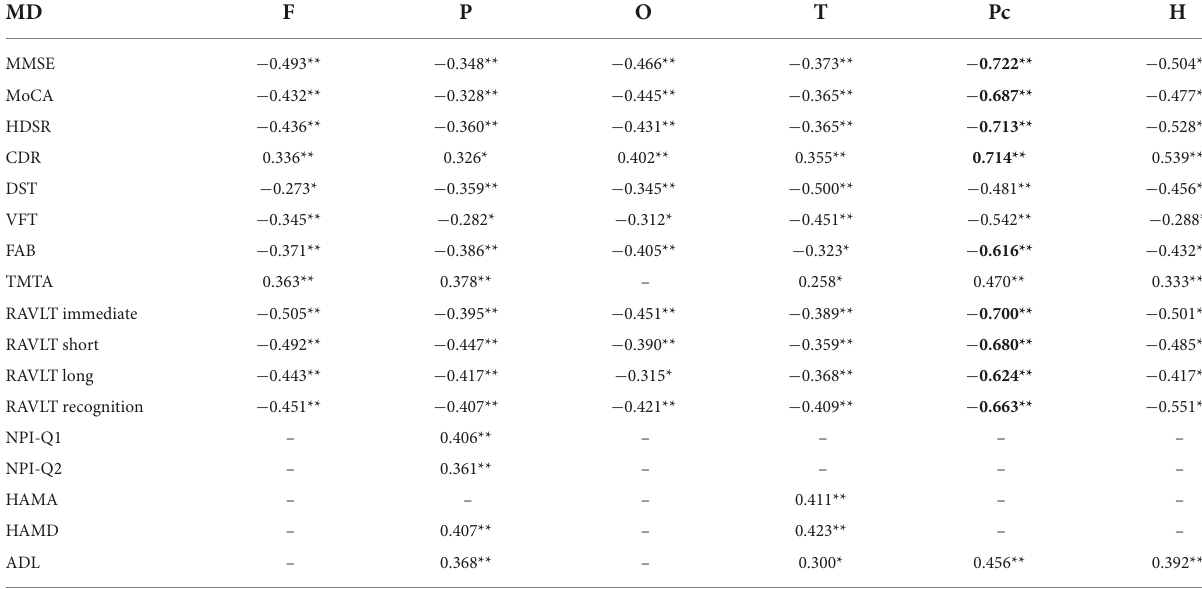
TABLE 6 Pearson’s correlation analysis between MD and neuropsychological test.